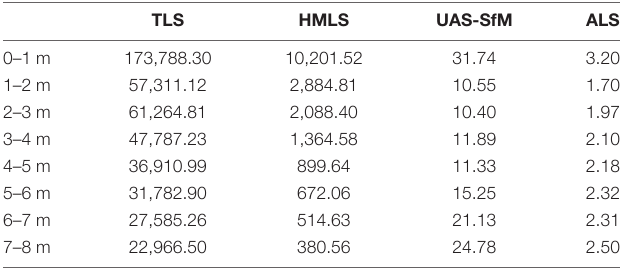
TABLE 3 | Average plot-level point density (points/m 2 ) by